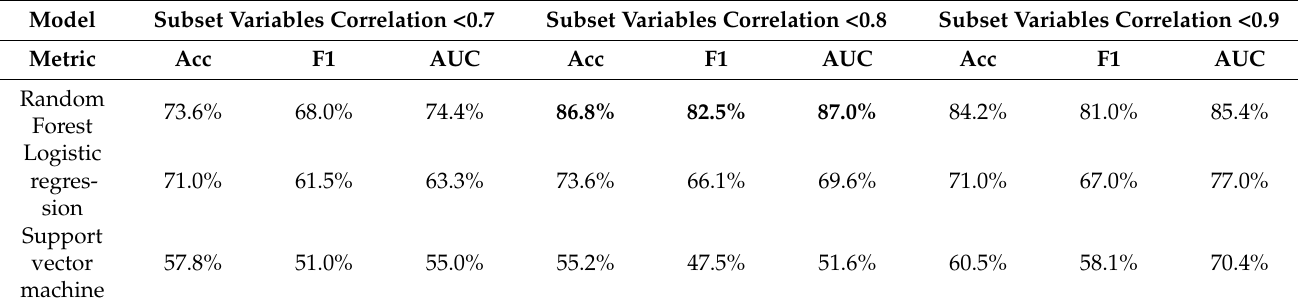
Table 8. Comparison of performance as regards the balanced accuracy of the models